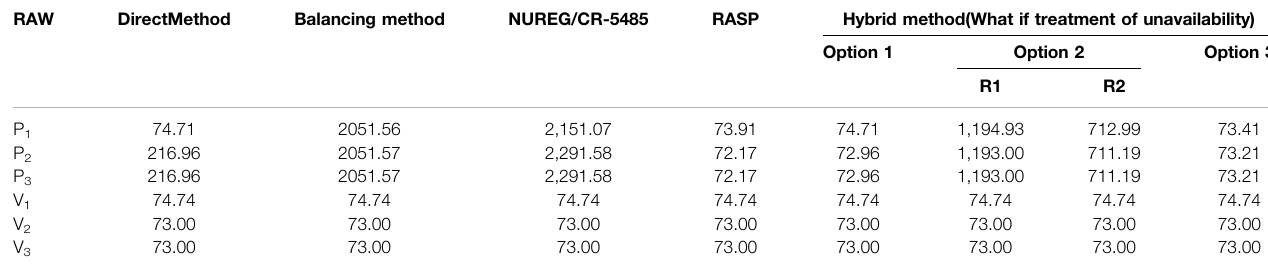
TABLE 3C | RAW importance results of different methods (t (cid:2) 720 h). RAW